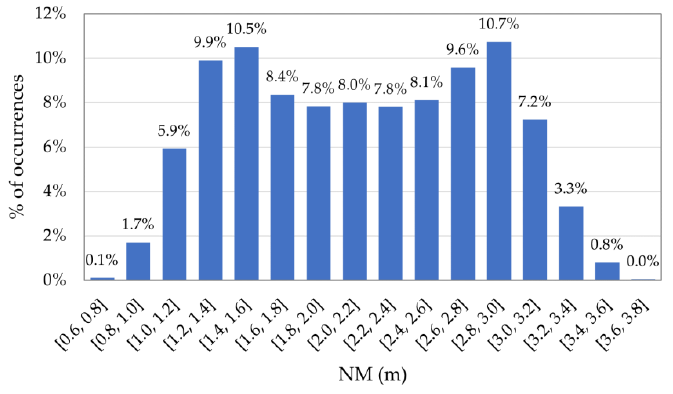
Figure 7. Intervals of sea level and percentage of